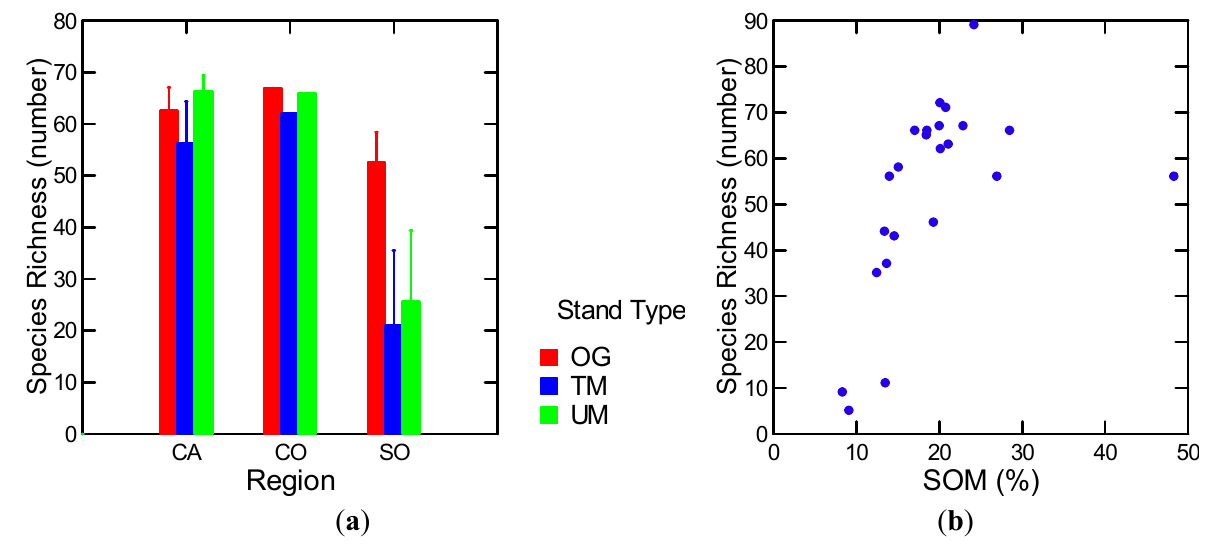
Figure 8. ( a ) Species richness of soil mesofauna by region and stand type (complete data for only one site in the Coast Range). CA = Cascades; CO = Coast Range; SO = Siskiyous; Bars = Standard Errors; ( b ) Species richness of soil mesofauna as related to percent soil organic